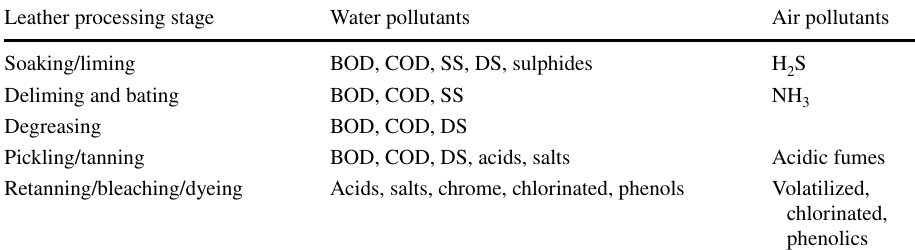
Leather processing